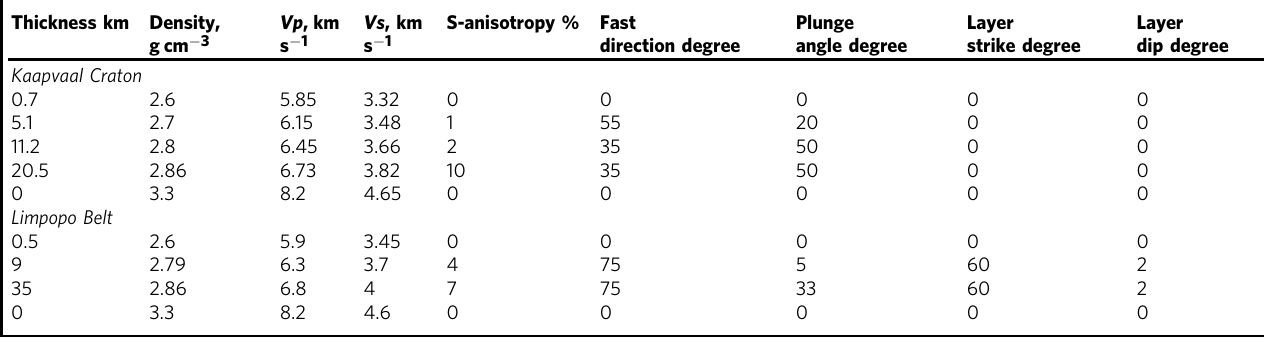
Table 1 Preferred anisotropic velocity models based on >400 test models, suggesting that the 20-km-thick lower crust is highly anisotropic ( δ Vs > 10%) in the Kaapvaal and Zimbabwe cratons, and moderately anisotropic (7% throughout the crust) in the Limpopo Belt. The difference in plunge angle explains variation in relative arrival time between radial SV and transverse SH phases: SH is faster than SV in Limpopo Belt and SV is the fastest in the cratons.